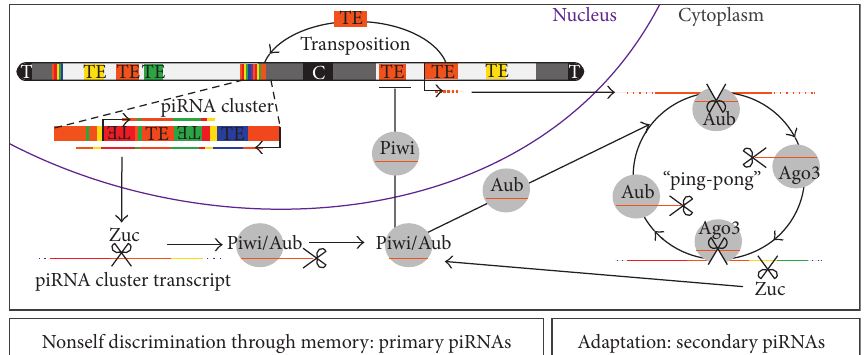
Figure 1: Mechanisms of “nonself” discrimination and adaptation in piRNA-guided defense against transposons in Drosophila . PiRNA clusters are genomic intervals that accumulate defunct fragments of transposable elements (TE) as a record of prior mobile activity. (1) Cluster regions are unidirectionally or bidirectionally transcribed and give rise to long presumably single stranded transcripts. PiRNA cluster transcripts are specifically processed into primary piRNAs by the consecutive action of at least two nucleases. The endonuclease Zucchini (Zuc) generates the 5 󸀠 terminus of a primary piRNA that is loaded into Piwi or Aubergine (Aub) and then trimmed by a 3 󸀠 -5 󸀠 exonuclease. Piwi-piRNA complexes enter the nucleus and recruit chromatin modifying enzymes to silence transposon loci. In contrast, Aub- piRNA complexes initiate an adaptive response against transposon transcripts in cytoplasmic germ granules. (2) Aub and Ago3 engage in a feed-forward adaptation mechanism—the “ping-pong” cycle—that degrades transposon transcripts and concomitantly produces secondary piRNAs to selectively enhance the response against active elements. Through a feedback mechanism secondary piRNAs can initiate further Zuc-dependent piRNAs that are loaded into Piwi and Aub (Centromere (C), Telomere (T)).